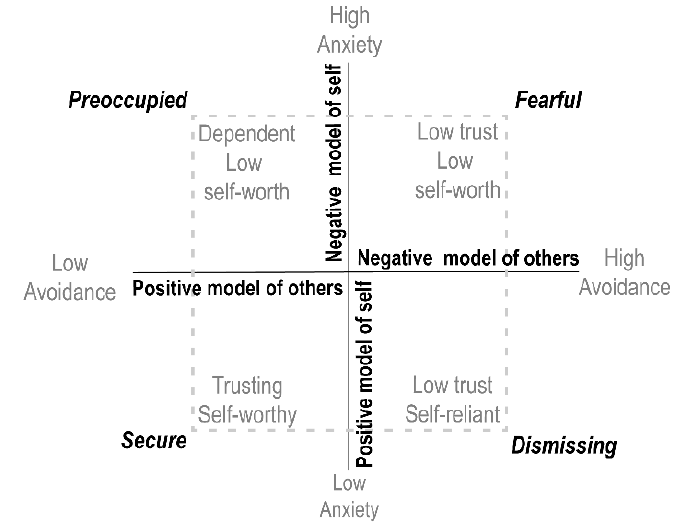
Figure 1. Four attachment styles based on two-dimensional approaches. This figure shows attach- ment styles based on two concepts. First, Brennan and colleagues’ two-dimensional components: the anxiety dimension (Y-axis) and avoidance dimension (X-axis) [21], and second, Bartholomew and Horowitz’s self/other model: self model (X-axis) and other model (Y-axis) [6]. The four quadrants produced by the two axes reflect secure, preoccupied, fearful, and dismissing attachment styles. For example, the preoccupied style is characterized by low avoidance and high anxiety according to the first concepts, and a positive model of the other and a negative model of self according to the second concept.